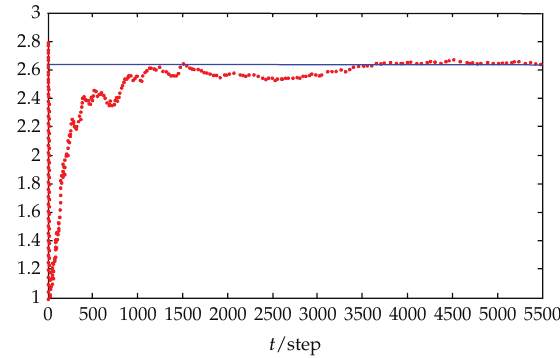
(cid:11) Q ε 2 (cid:5) t (cid:6) .